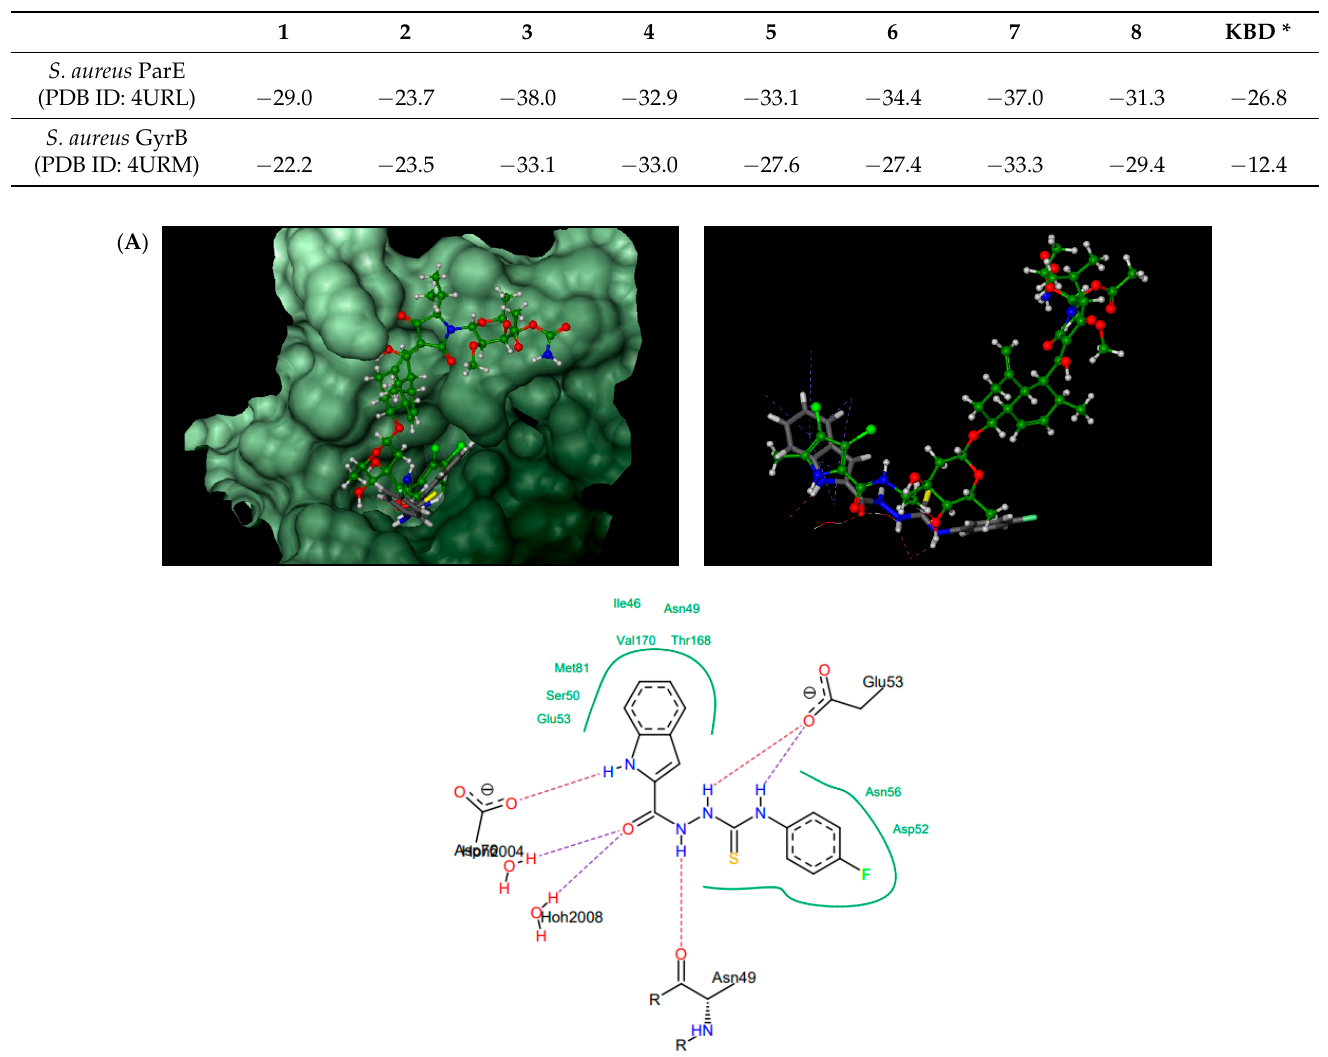
Table 1. Scores of top poses of thiosemicarbazides 1 – 8 docked to proteins: PDB entry: 4URL ( S. aureus 43 kDa ParE) and